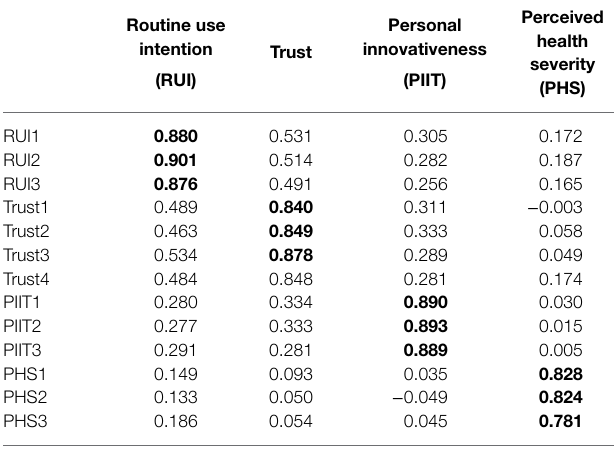
TABLE 4 | Loadings and cross-loadings for measurement